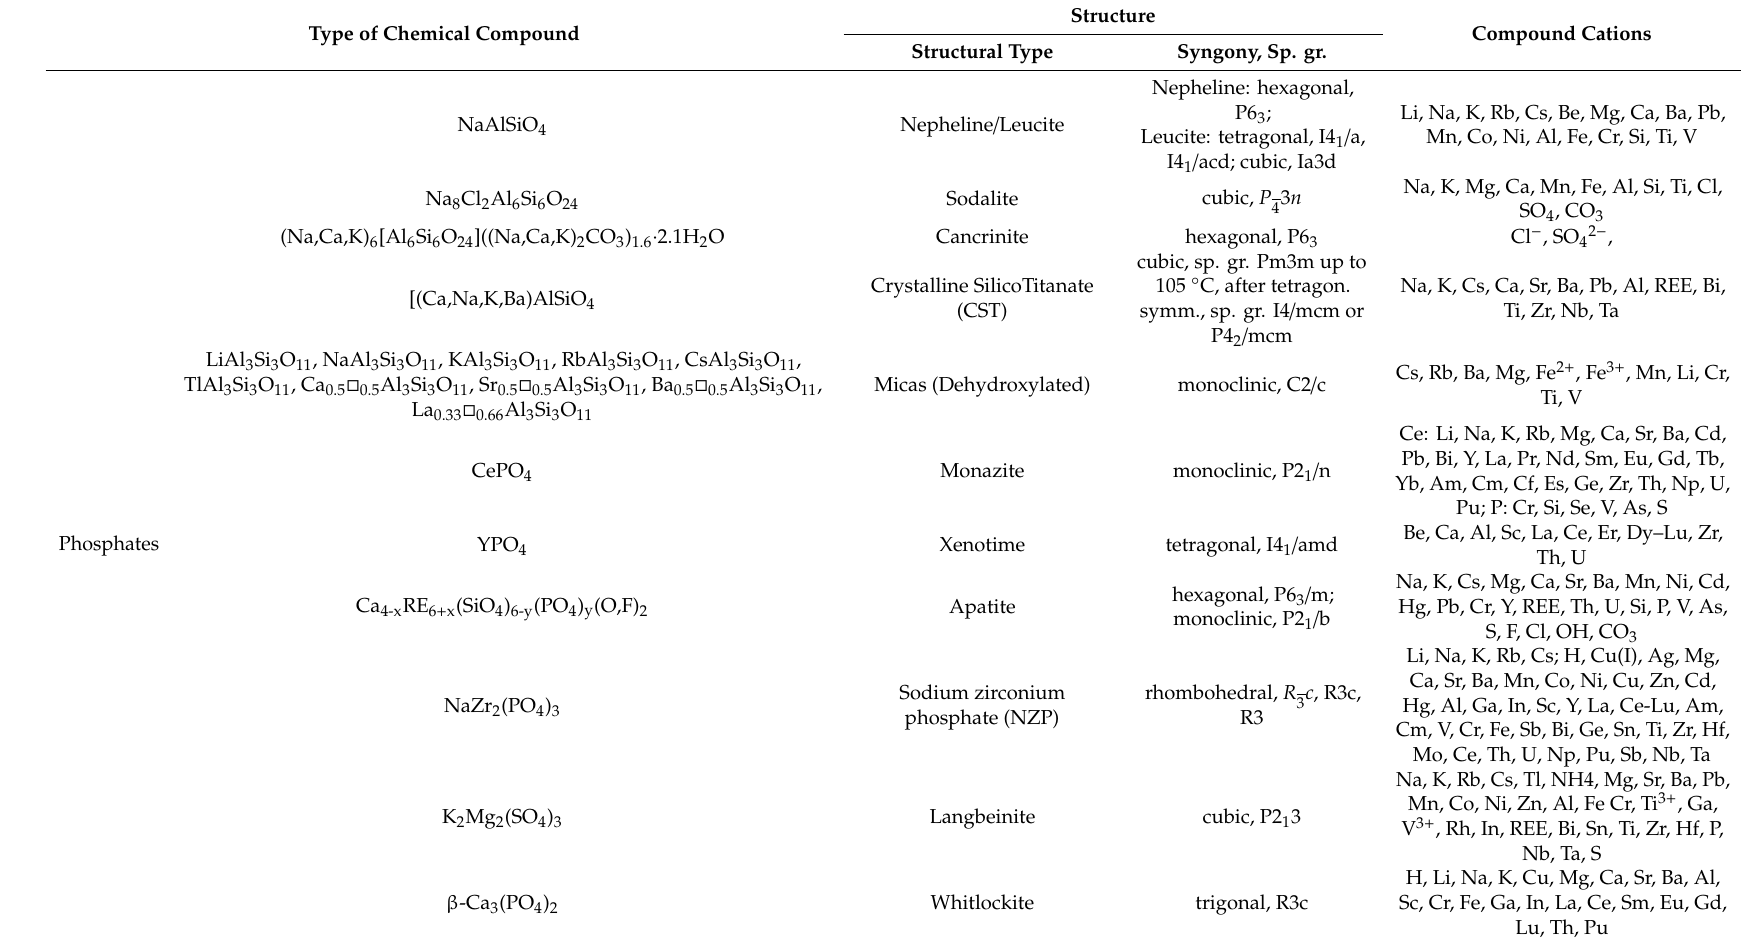
Table 1. Crystalline ceramic materials as potential forms for nuclear waste